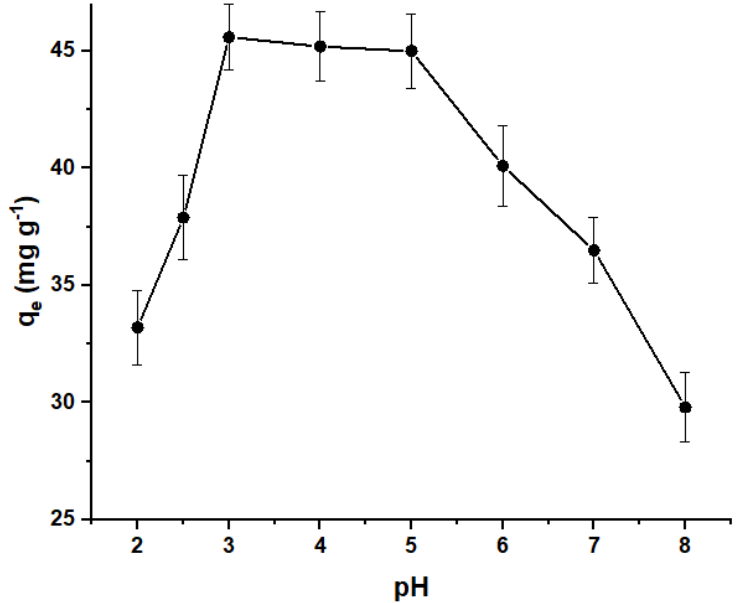
Figure 5. Effect of pH on the removal of COD by the activated carbon.